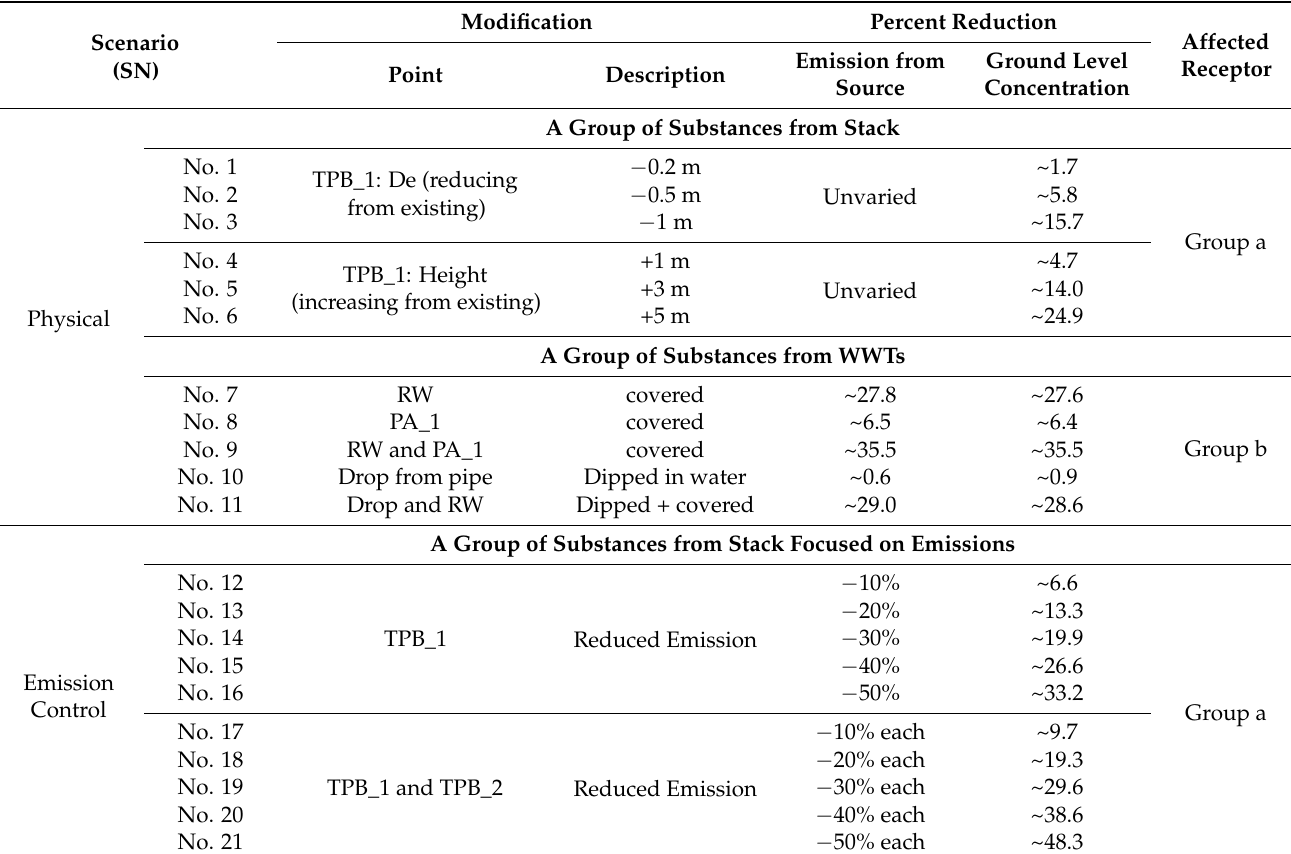
Table 4. Summary of changes resulting from model